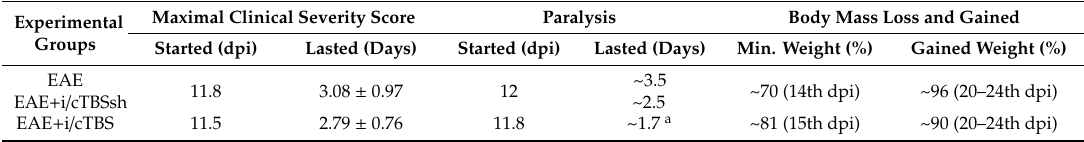
Table 1. Alleviation of EAE clinical symptoms by iTBS and cTBS in rats.